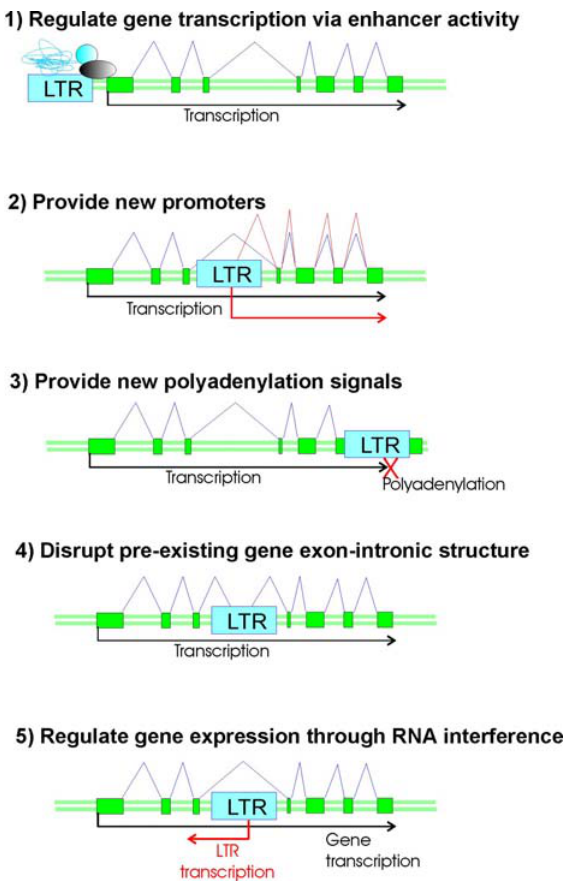
FIGURE 5. Five potential mechanisms that comprise the recruitment of human-specific endogenous retroviruses for modulating activity of pre-existing genes. At present, direct experimental evidence has been provided for the in vivo enhancer, promoter, and transcription termination activities of the human-specific endogenous retroviruses (see text).